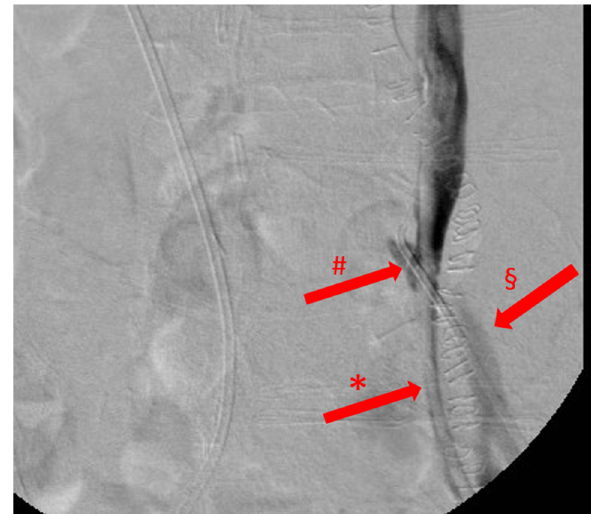
Figure 4: Retrograde ureterography, image with no digital subtrac - tion, frontal view, case 2, fi rst episode. Iodinated contrast leak from the left ureter into the distal left common iliac artery. *: left ureteral stent; §: left common iliac artery; and #: